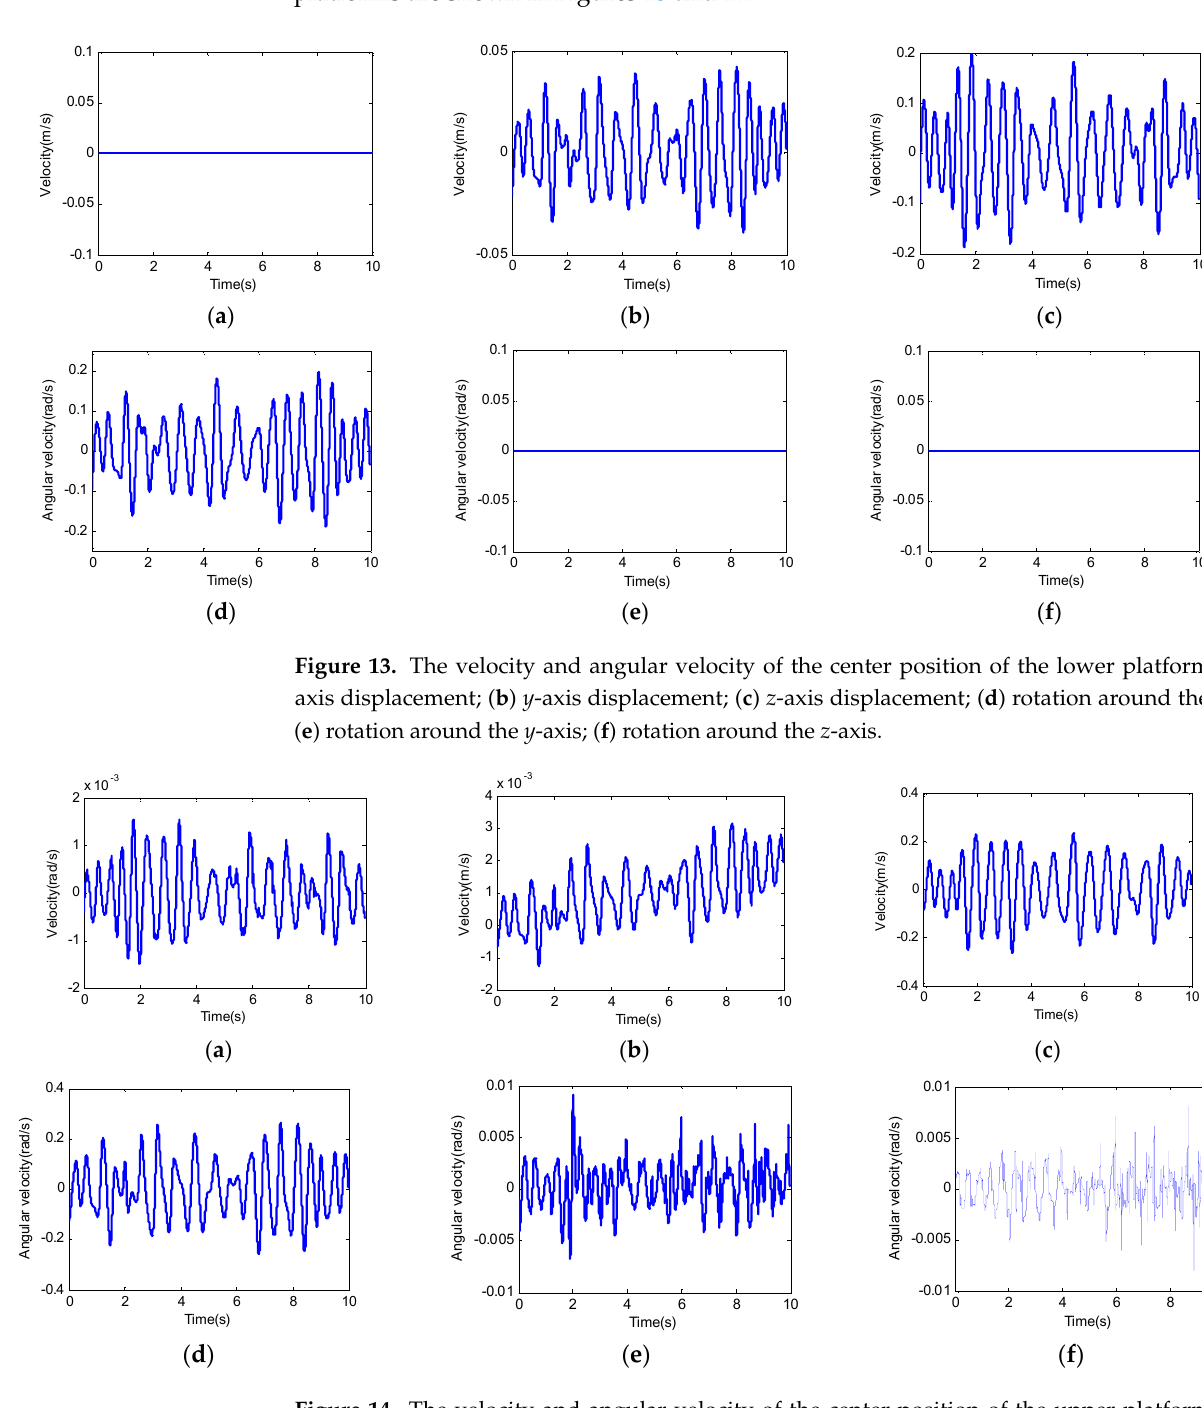
Figure 14. The velocity and angular velocity of the center position of the upper platform: ( a ) x -axis displacement; ( b ) y -axis displacement; ( c ) z -axis displacement; ( d ) rotation around the x -axis; ( e ) rotation around the y -axis; ( f ) rotation around the z -axis.